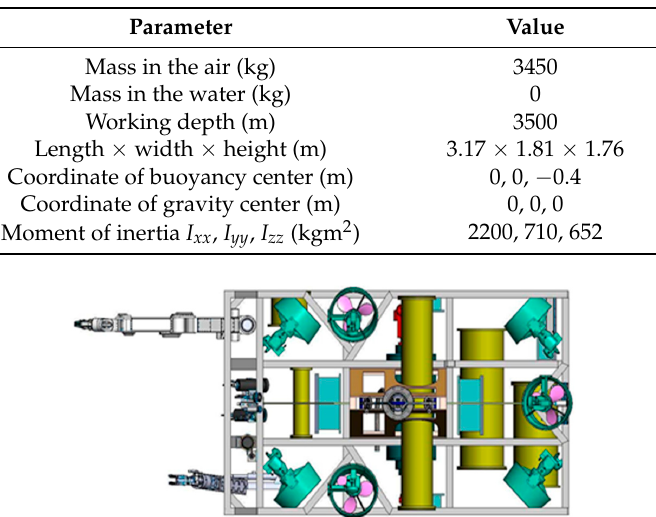
Figure 2. Thruster configuration of ROVs.